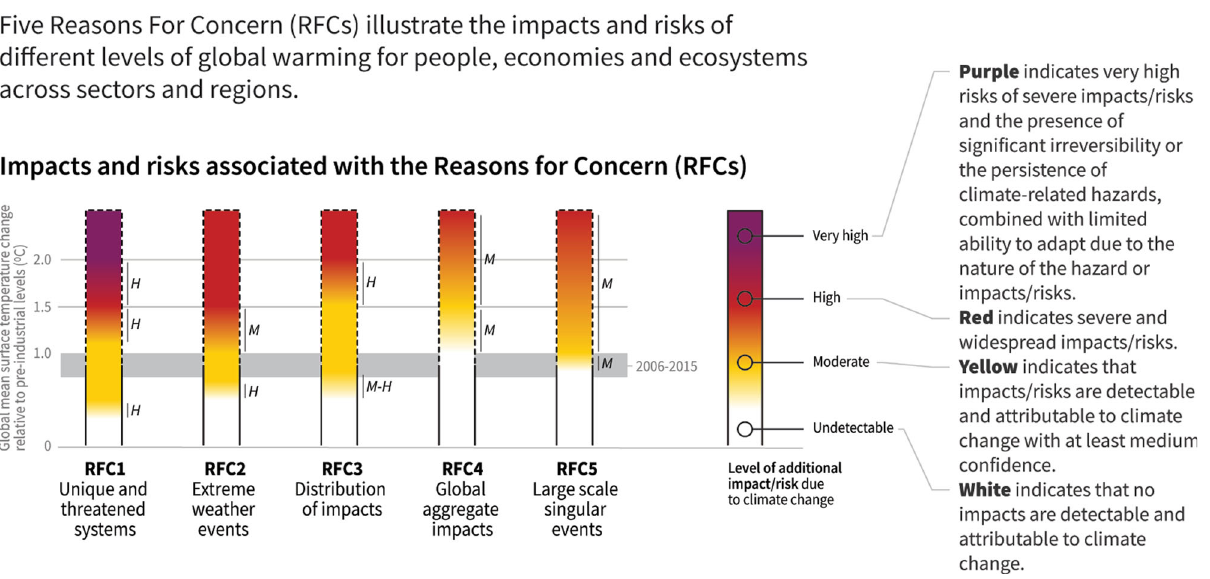
Fig. 1 The assessment of impacts and risks of climate change in IPCC Reasons for Concern framework. Reproduction from Fig. SPM2 of the IPCC Special Report on the Global Warming of 1.5 °C (SR1.5) 1